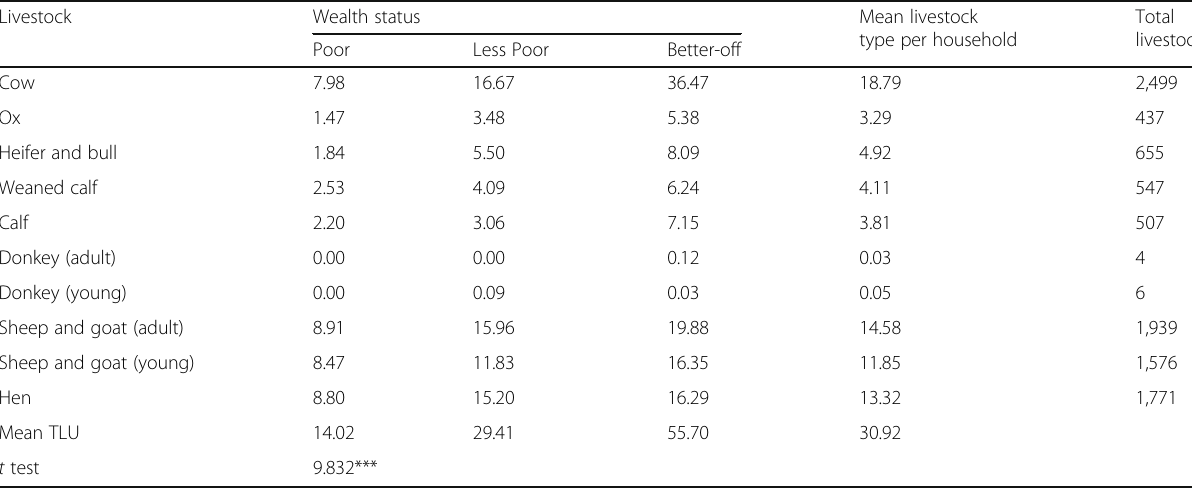
Table 4 Livestock possession of the households ( N = 133)